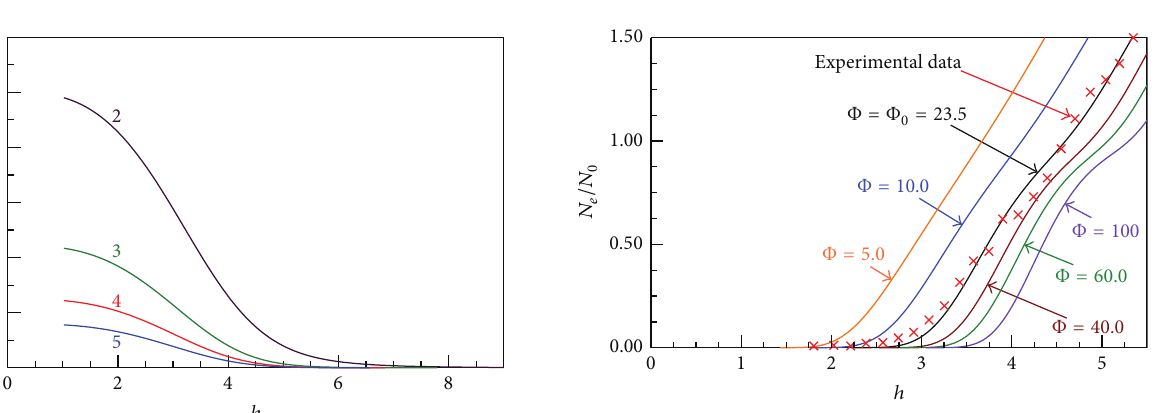
Figure 1: The ratios 𝜏 𝑗 (ℎ)/𝜏 1 (ℎ) (7) for the lowest quantum levels 𝑗 = 2; 3;4; 5 as a function of the slit width ℎ . The curves are marked by the values of 𝑗 . These functions are the same for 1D and 2D roughness and in the biased diffusion approximation do not depend on the roughness parameters.